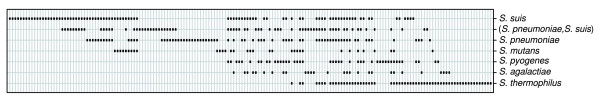
Positive selection occurrence per genes and lineages. A black dot indicates positive selection. The genes and lineages were ordered following a correspondence analysis.